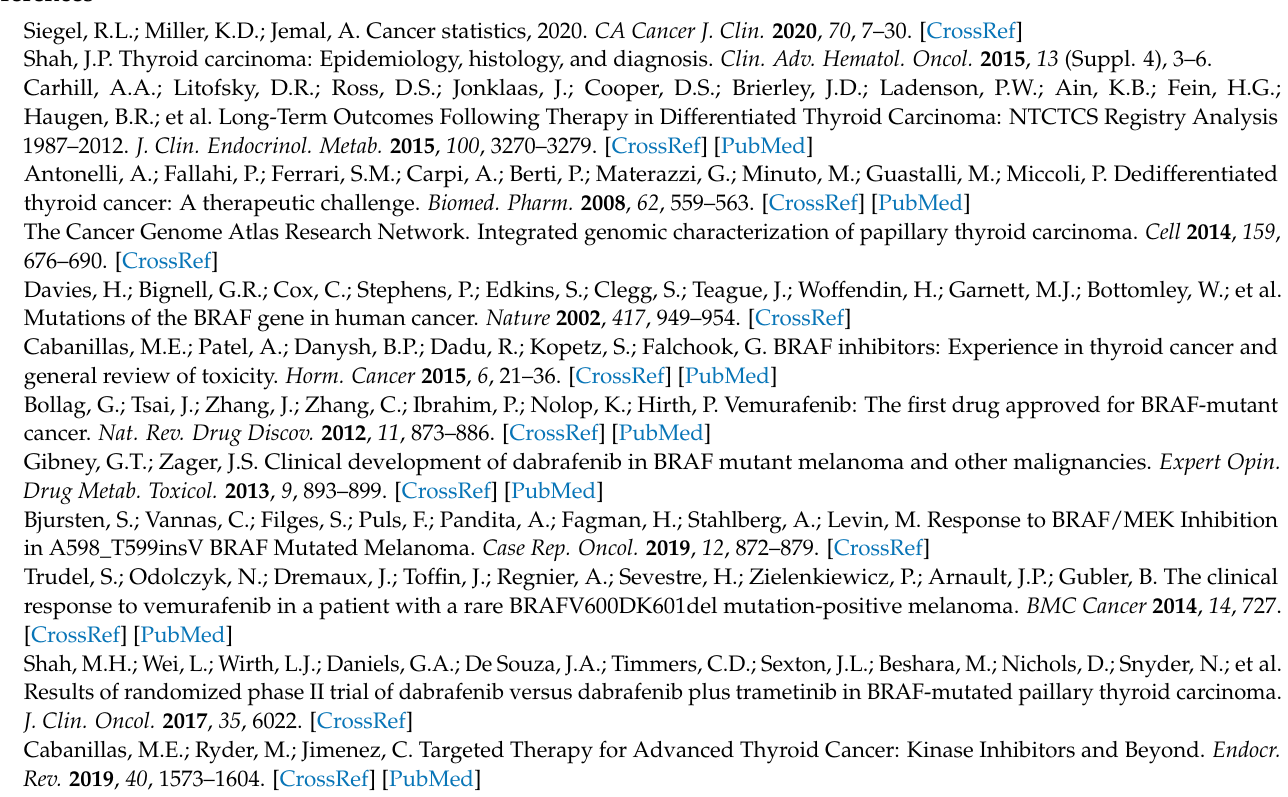
Table S2: T200.1 Gene Panel. Table S3: Primary and secondary antibodies. Table S4: List of probed proto-oncogenes located on chromosome 7. Table S5: TaqMan and IDT probes/primers used for RT-qPCR and copy number